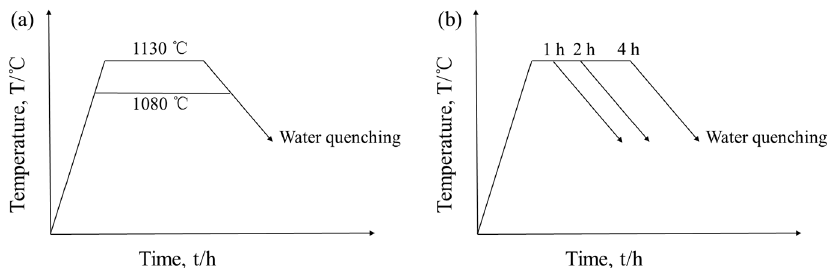
Figure 1. Experimental process for the solution treatment: ( a ) solution treatment temperature; ( b ) solution treatment time.